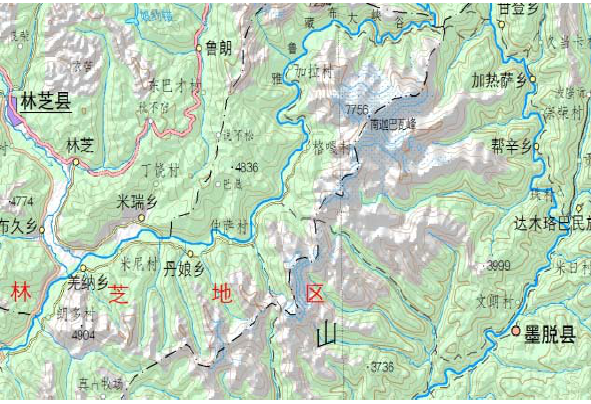
Figure 2. Small sample plot of 1:1000000 topographic map